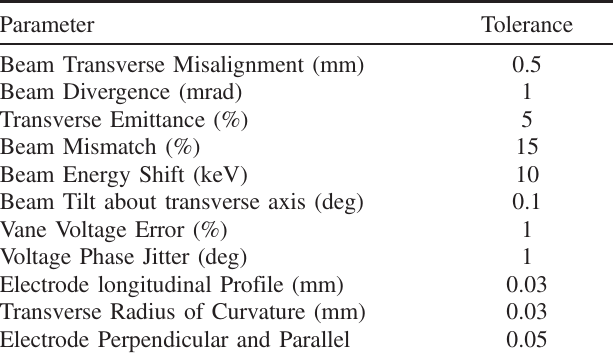
TABLE XII. Tolerances for MEHIPA derived from the error analysis.